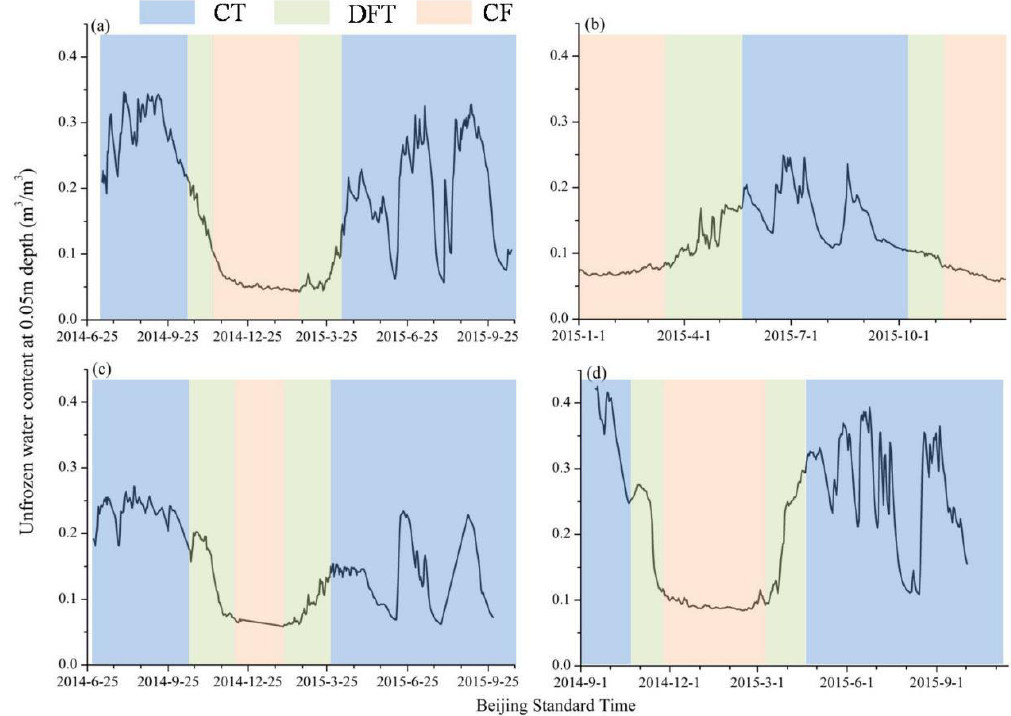
Figure 9. Changes of volumetric moisture content of unfrozen water in soil at 0.05 m depth during a freeze-thaw cycle at sites ( a ) Nierong, ( b ) TGLMS, ( c ) Naqu, and ( d ) Biru (CF, complete freezing; DFT, daily freeze-thaw cycle; CT, complete thawing).